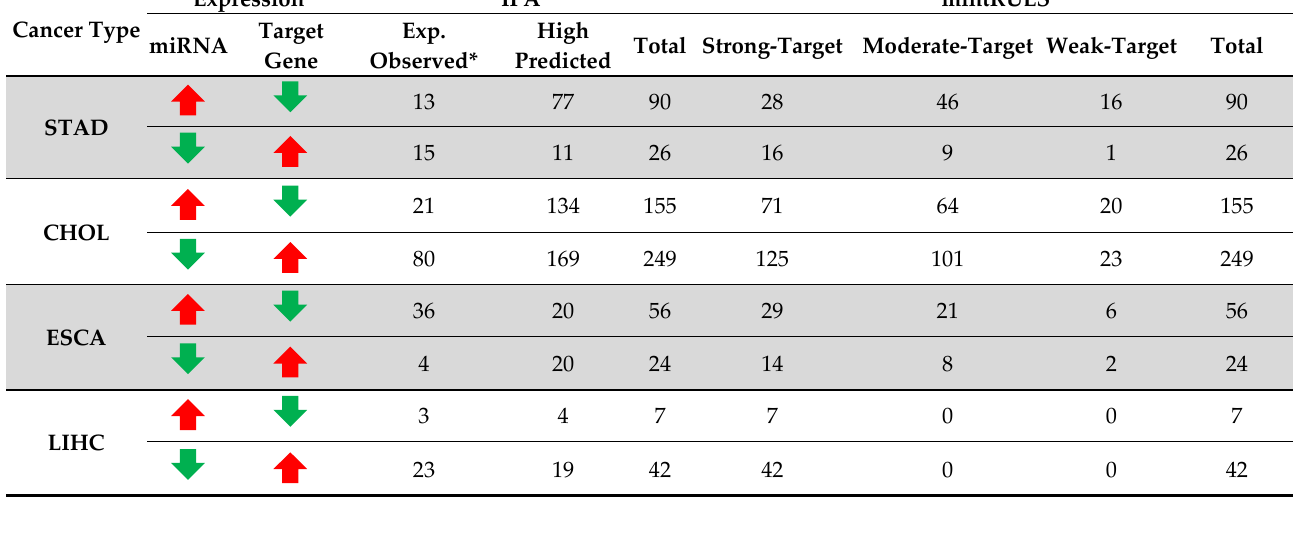
carcinoma. Upward red arrow: upregulation, downward green arrow: down regulation.